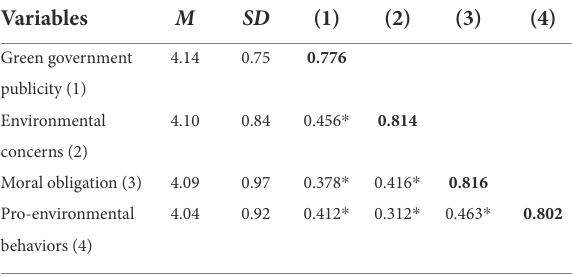
TABLE 2 Descriptive statistics and correlations among indicator